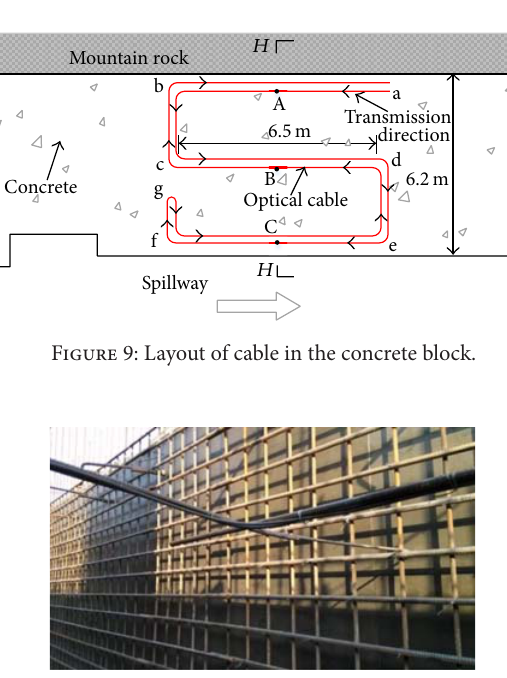
Figure 10: The optical cable fastened in the middle plane of the concrete